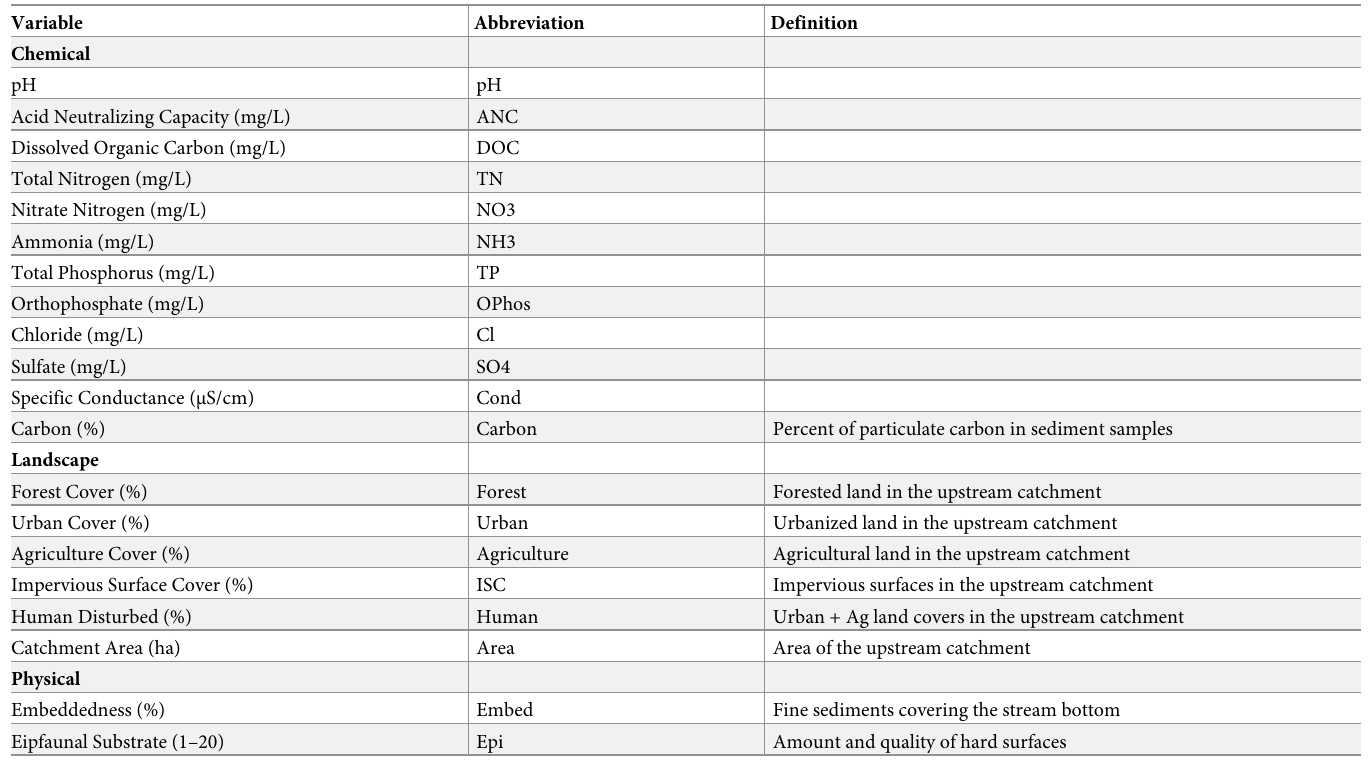
Table 1. Environmental variables used in the gradient forest analysis.